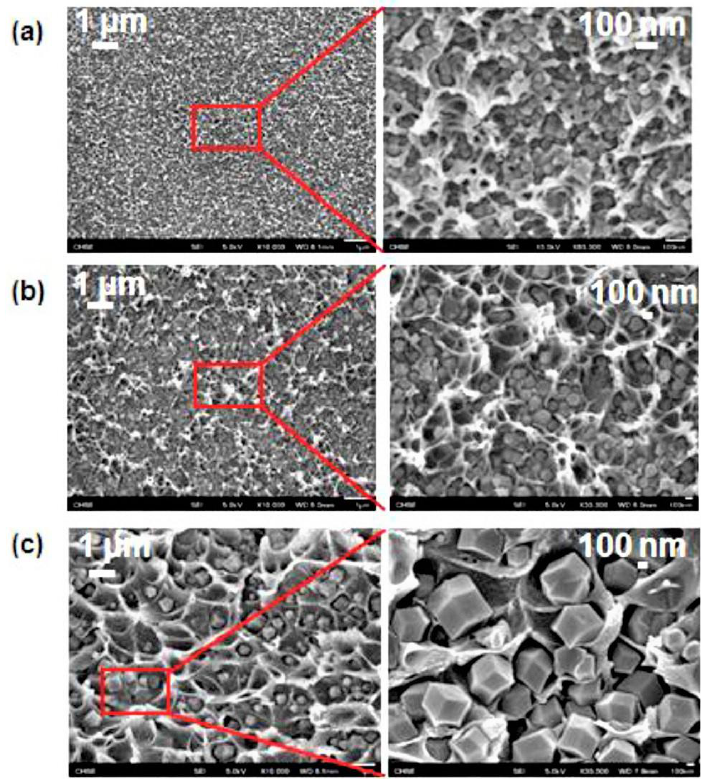
Figure 4. Cross-sectional morphology of 6FDA-Durene containing ZIF71 particles with average size of 30 nm ( a ); 200 nm ( b ); and 600 nm ( c ) [76], with copyright permission from © 2016, American Chemical Society